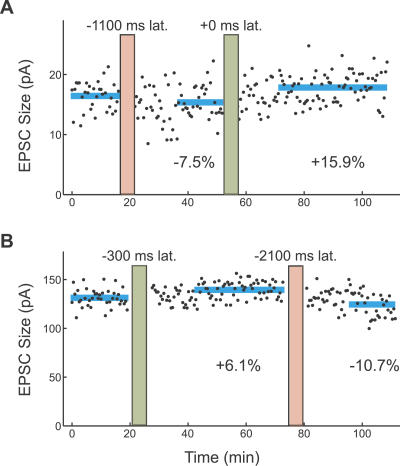
The Effects of Retinal Waves Are Cumulative over TimeTwo examples of experiments demonstrating the cumulative effect of two opposing stimulation protocols: (A) −1,100-ms latency (lat.) pairing followed by zero-latency pairing; and (B) −300-ms latency pairing followed by −2,100-ms latency pairing. Horizontal blue lines represent the mean EPSC size, and vertical green and red boxes demonstrate the duration of the stimulation protocol.